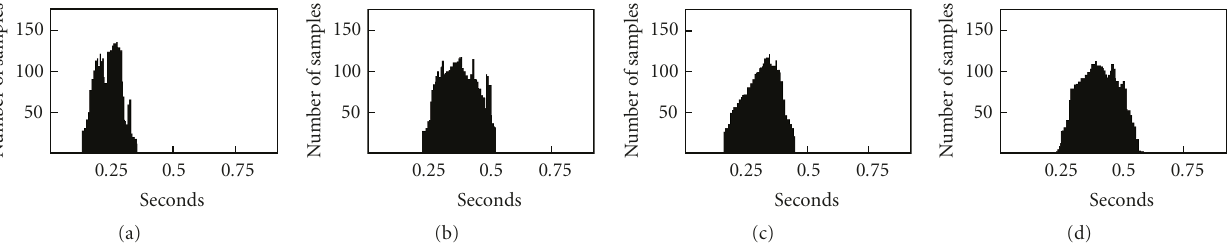
Figure 15: Response times of (a) Proposed, (b) Daugman [5], (c) Monro et al. [15], and (d) Ma et al. [7] methods using Bath iris